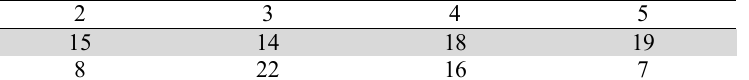
Holding cost and Backorder Cost for Customer i Customer